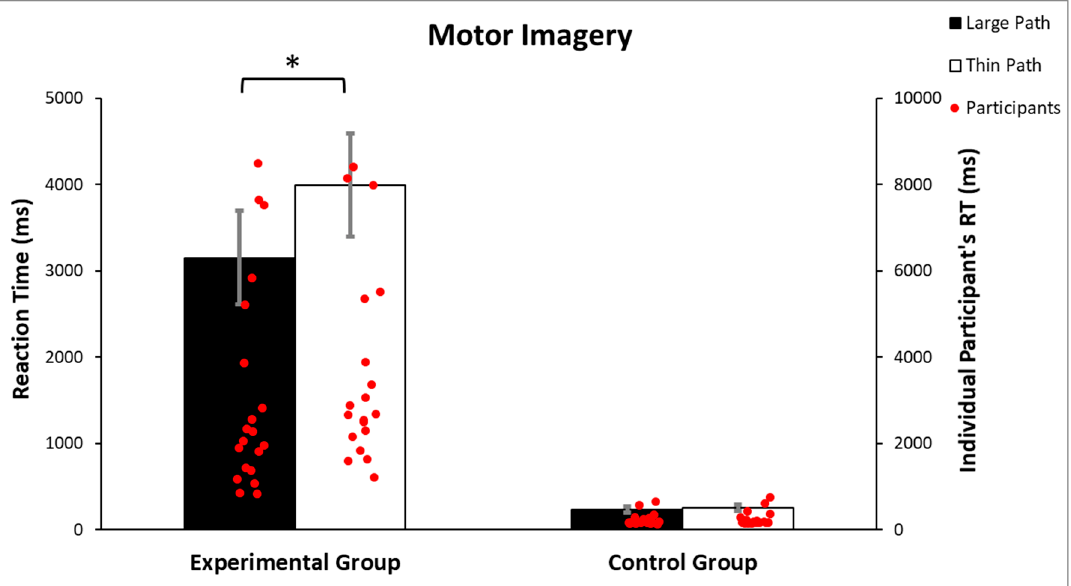
Figure 5. Analysis of the motor imagery time illustrates that the path width had an influence on the response time only in the experimental group. Vertical lines indicate the standard error of mean (SEM), * p < 0.001.